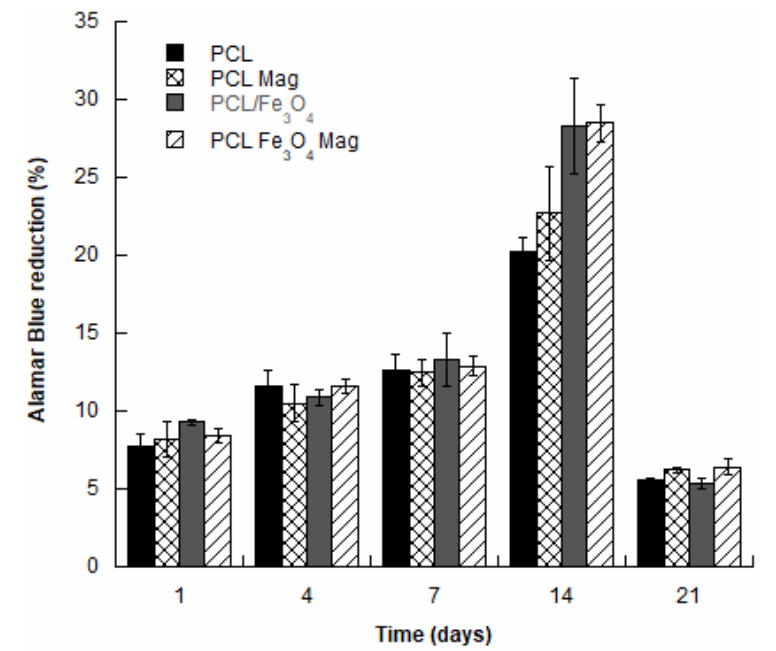
Figure 3. Percentage of Alamar Blue reduction evaluated for PCL, PCL/Fe ₃ O ₄ , PCL Mag and PCL/Fe ₃ O ₄ Mag at different time points.